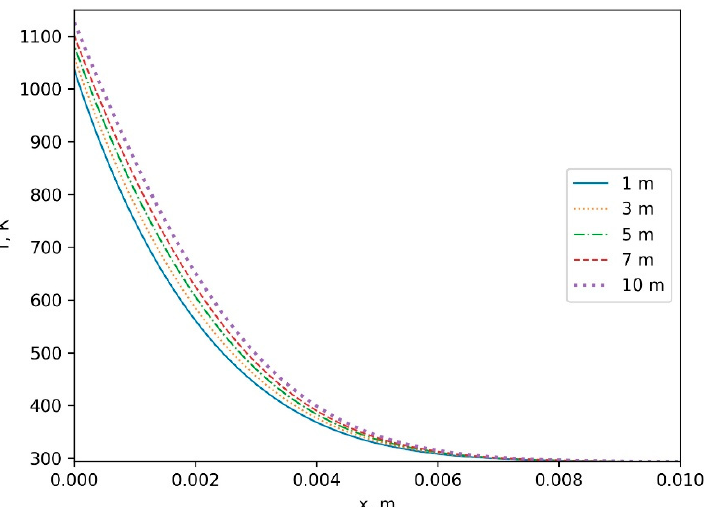
Figure 12. Impact of a crown forest fire on plywood from a distance of 20 m for different facade heights (from 1 to 10 m).